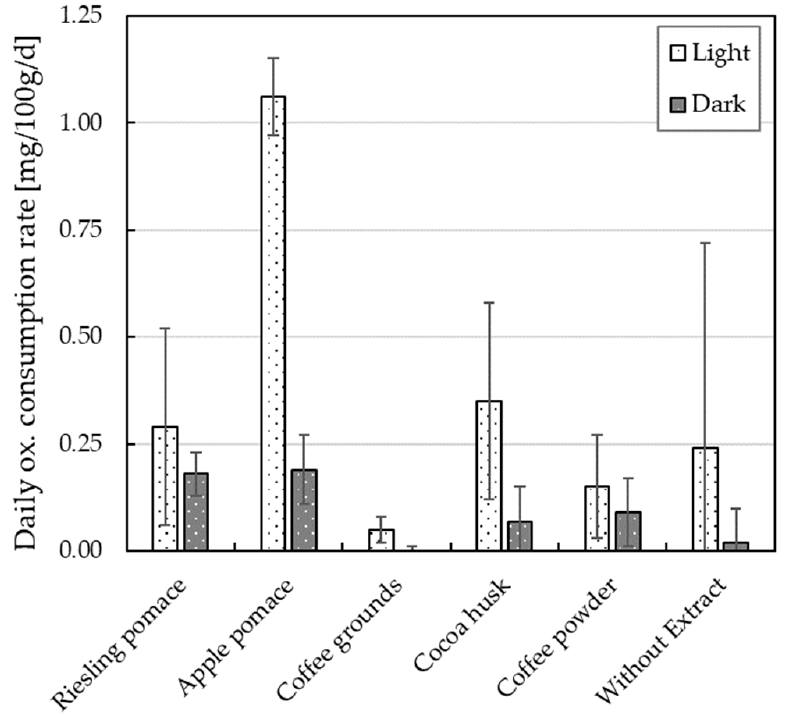
Figure 5. Daily oxygen consumption rate of O/W emulsions with plant extracts. The figure shows the daily oxygen consumption rate in mg O 2 per 100 g per day as a function of a storage time of 90 days at 30 °C for the O/W emulsions with and without extract in light and darkness, respectively, as mean values ( n = 3) with standard deviation (SD).